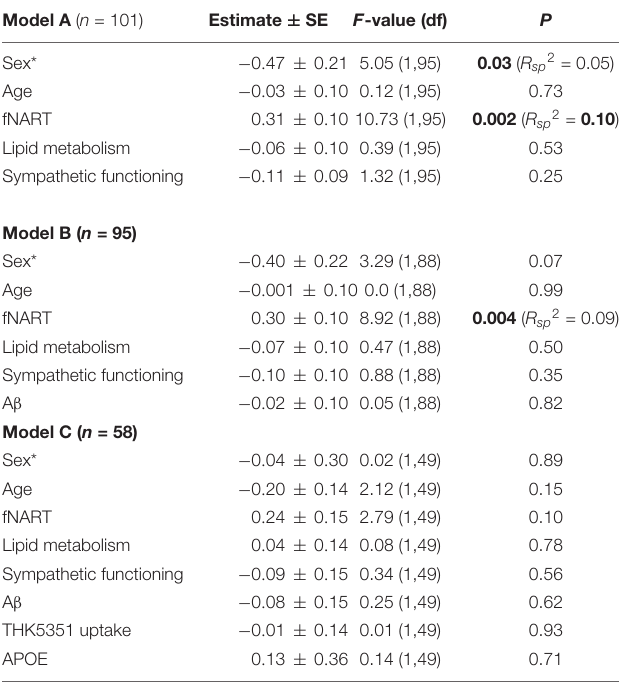
TABLE 3 | Statistical outcome of GLMM examining associations between episodic memory (dependent variable) and: (A) scores of cognitive reserve and allostatic load ( n = 101); (B) scores of cognitive reserve and allostatic load, and A β (n = 95); (C) scores of cognitive reserve and allostatic load, A β , tau, and APOE ( n = 58).